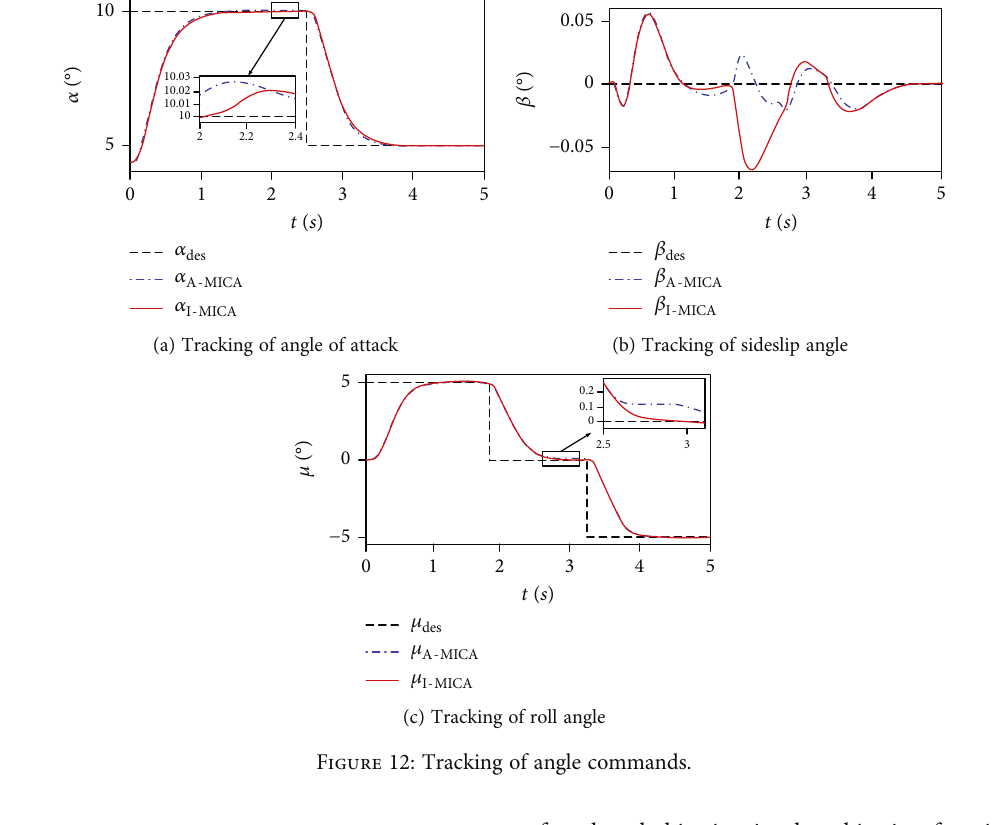
Figure 12: Tracking of angle